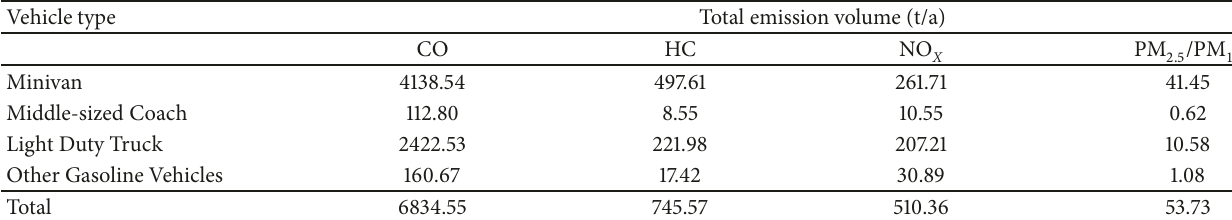
Table 12: Pollutant emission inventory of gasoline vehicle in Zibo City.